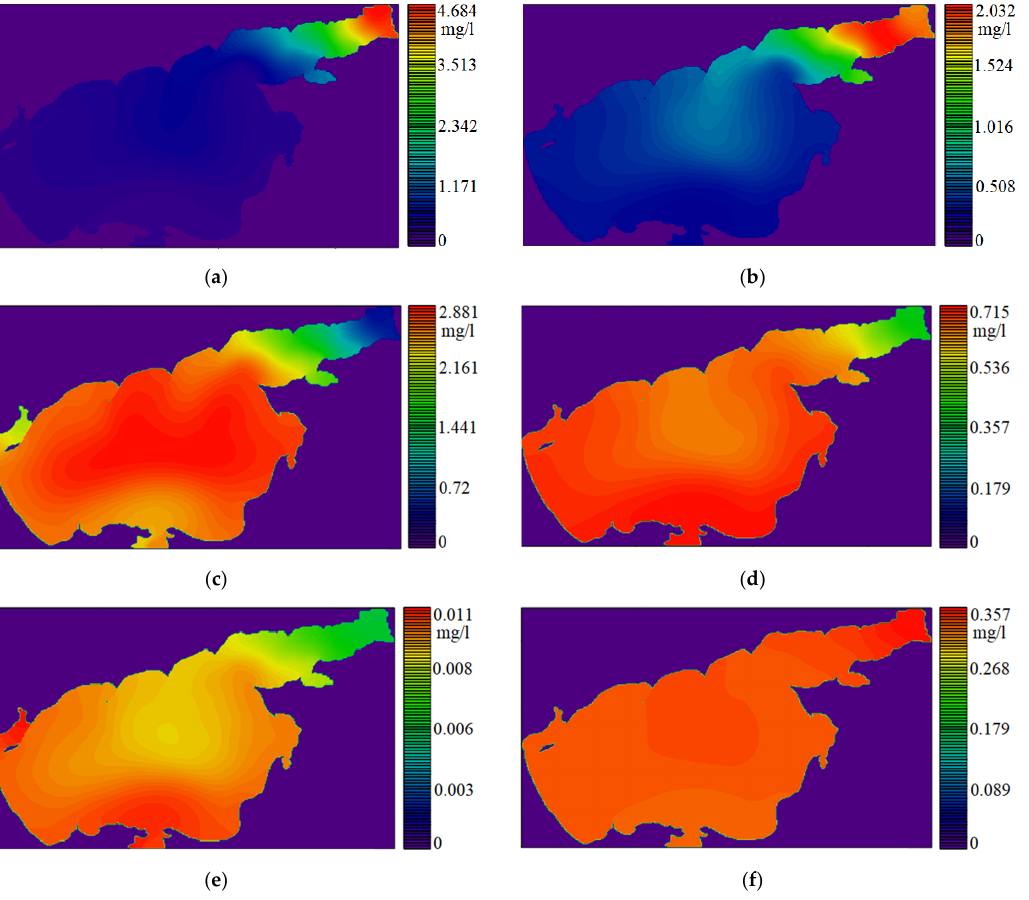
Figure 2. Surface values of substance concentrations in the warm season: ( a ) Chlorella vulgaris ; ( b ) Aphanizomenon flos-aquae ; ( c ) Chlorella vulgaris ; ( d ) phosphates ( PO 4 ); ( e ) nitrates ( NO 3 ); ( f ) dissolved inorganic silicon ( Si ).